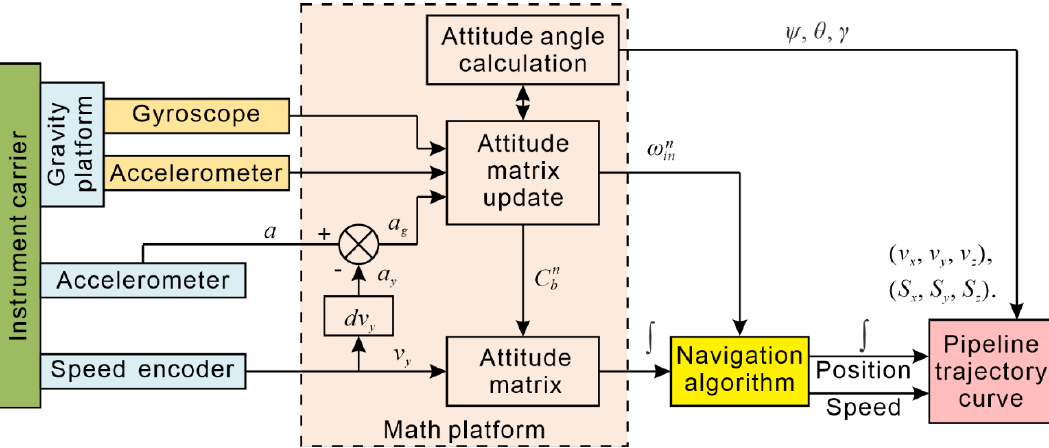
Figure 3. Schematic diagram of the pipeline trajectory inertial measurement system.